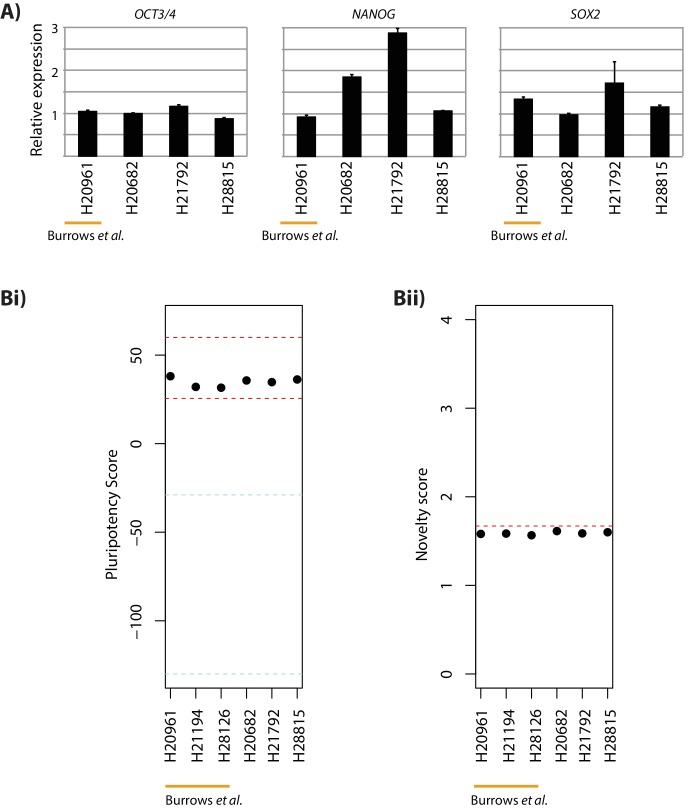
Human fibroblast-derived iPSCs exhibit gene expression profiles consistent with pluripotent cells.(A) Expression of the core pluripotency genes OCT3/4, NANOG and SOX2 relative to GAPDH determined by qPCR. Error bars represent standard deviation from three technical replicates (Bi) PluriTest-derived pluripotency scores (Muller et al.) as a measure of the overall pluripotency gene expression signature of each sample. The empirical range in which samples’ global gene expression profiles are consistent with known pluripotent cells is shown in red. Non-iPSCs fall in the score range indicated by the blue lines. (Bii) PluriTest-derived novelty score as a measure of contamination from differentiated cells. The empirical threshold (1.67) below which samples’ gene expression profiles are consistent with known pluripotent stem cells is shown in red. Fibroblast-derived iPSCs previously described in Burrows et al. are shown for comparison.